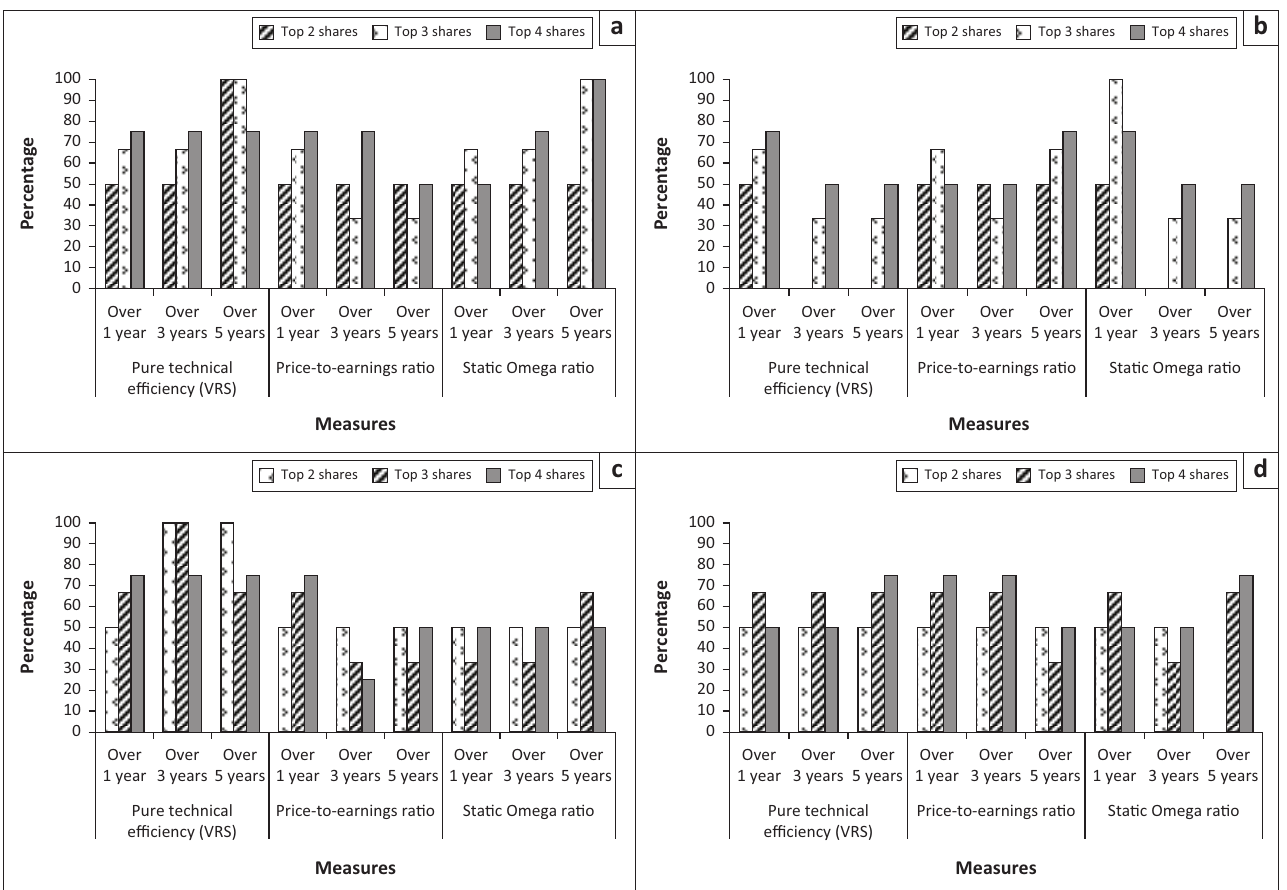
FIGURE 2: Average ability of pure technical efficiency (VRS), the P/E ratio and static Omega ratio to select the top performing banking shares: (a) 2004; (b) 2005; (c) 2006; (d) 2007; (e) 2008; (f) 2009; (g) 2010 and (h)